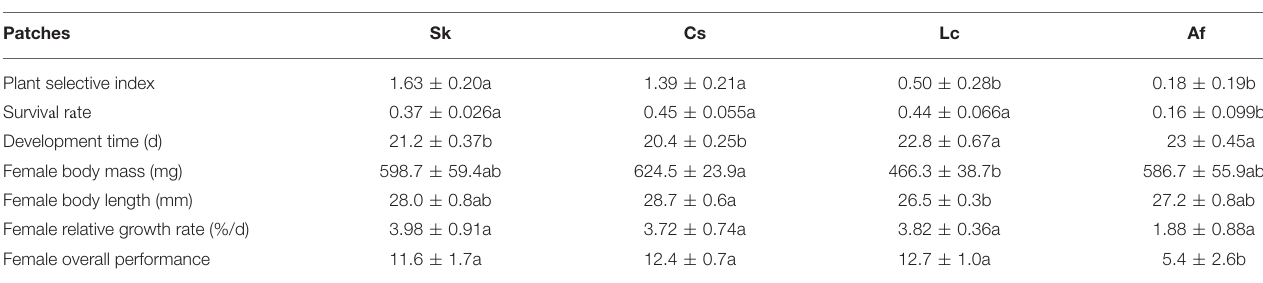
(Supplementary Table 5). Down-regulated genes included protein kinase (AKT), and aspartate aminotransferase (GOT) (Supplementary Table 5; Supplementary Datasheets 6, 9,